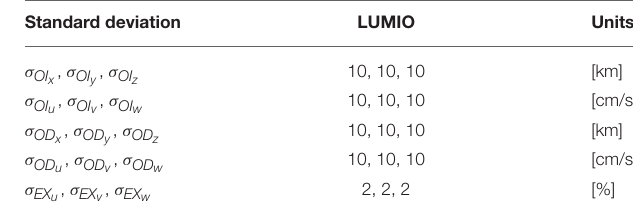
TABLE 9 | Standard